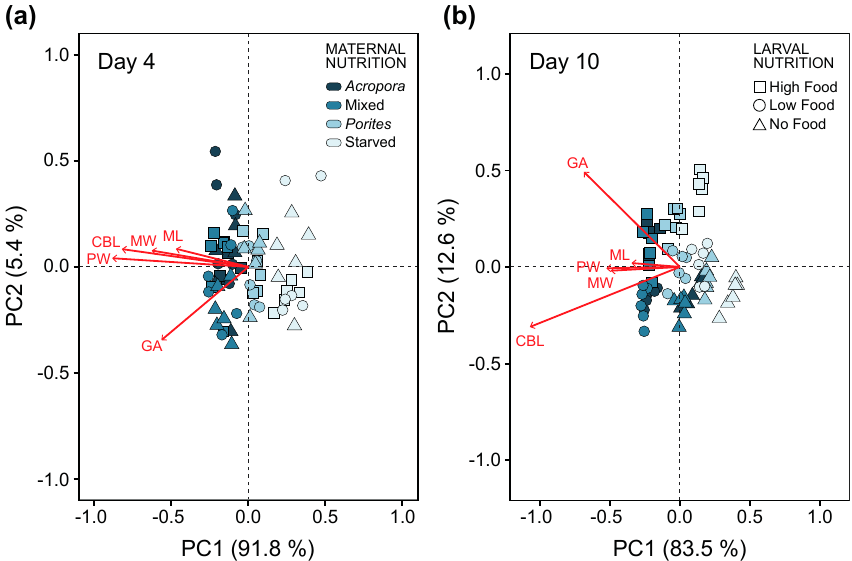
Figure 7. Principal component analysis (PCA) plot of morphological traits measured to analyze similarities in larval morphology at ( a ) four days and ( b ) ten days after the onset of feeding ability. Red vectors are morphometric measurements of maximum length ( ML ), maximum width ( MW ), posterior width ( PW ), ciliated band length ( CBL ), and gut area ( GA ). Maternal nutrition treatments are indicated by different colors and larval feeding treatments are indicated by symbols. Individual data points are average values from 10 replicate larvae per experimental bottle.